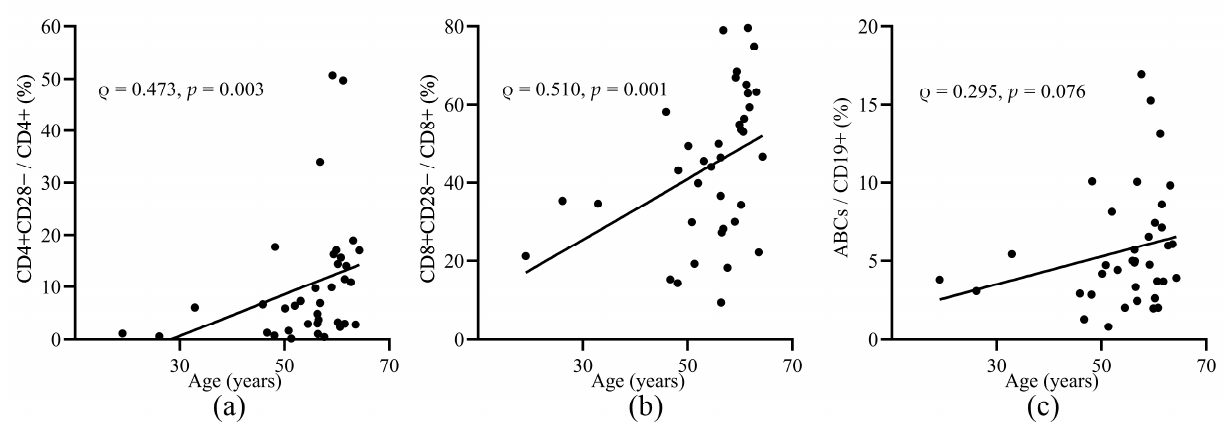
Figure 1. The correlation of the frequencies of aged T and B cell subsets and age before vaccination. Correlation of the frequencies of CD4+CD28 − T cells ( a ), CD8+CD28 − T cells, ( b ) and ABCs ( c ) and age of the patients before vaccination. ABCs, age associated B cells. Spearman’s rho and p -values are shown.